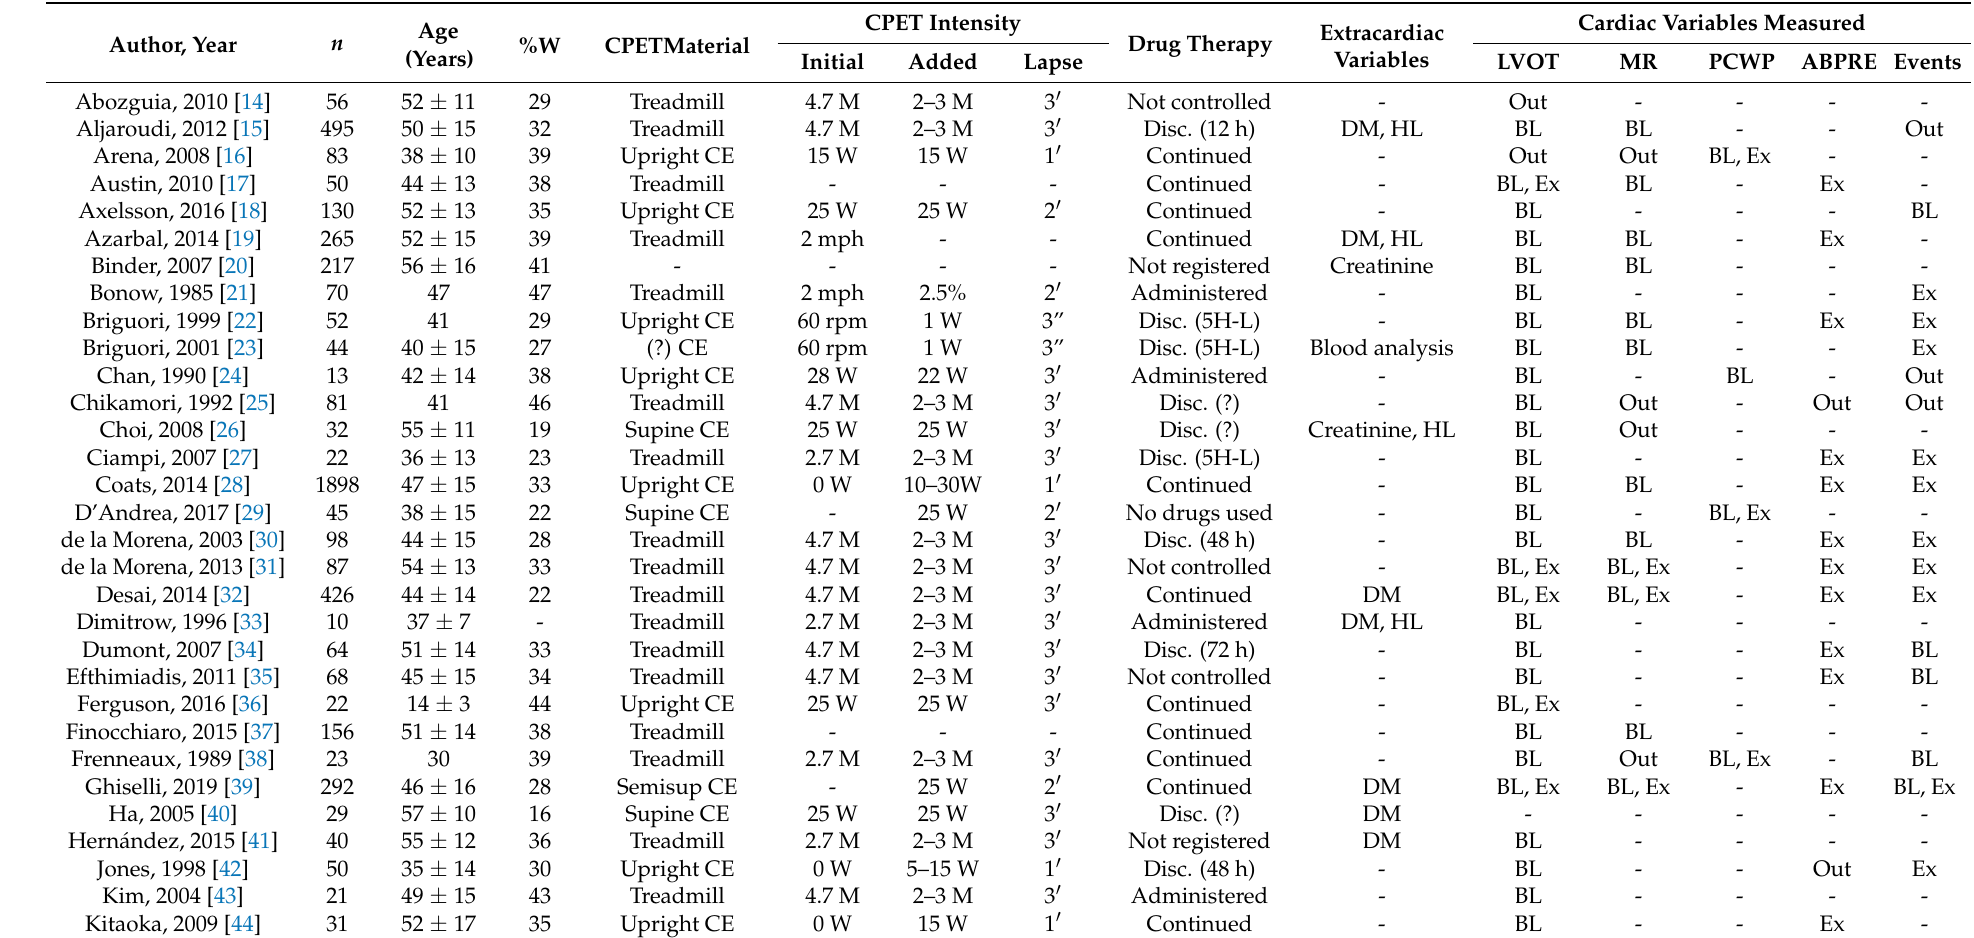
Table 1. Methodological characteristics of